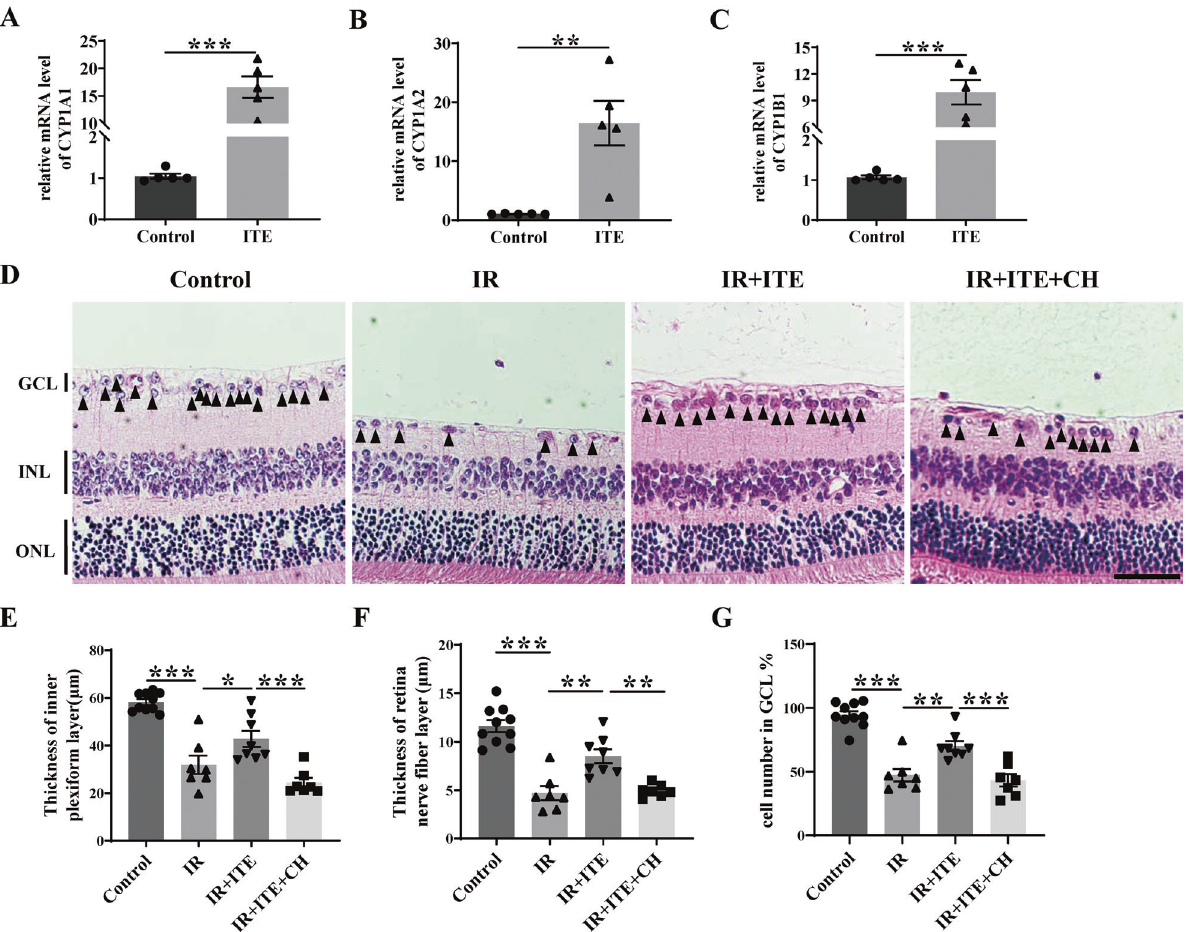
Fig. 3 The protective role of ITE in alleviating retinal injury was AhR activation dependent. Retinal ischemia/reperfusion injury model mice were intraperitoneally injected with ITE or CH223191 (10 mg/kg, inhibitor of AhR and abbreviated as CH below). A – C mRNA expression of CYP1A1, CYP1A2, and CYP1B1 were detected by qRT-PCR in the retina of mice with or without ITE administration for 24 h. D H&E staining showed different histology of retinas 7 days after IR. GCL ganglion cell layer, INL inner nuclear layer, ONL outer nuclear layer. Scale bars: 50 μ m. E – G Quantitative analysis of the thickness of inner plexiform layer and retina fi ber layer and cell number of ganglion cell layer were shown in histograms. Control, control group; ITE, ITE treatment; IR, ischemia/reperfusion injury; IR + ITE, IR with ITE treatment; IR + ITE + CH, IR with ITE and CH223191 treatment, n = 5 – 10 for each group. All data are presented as mean ± SEM, * P < 0.05, ** P < 0.01, *** P < 0.001, P value was obtained either by Student ’ s t test or by one way ANOVA followed by multiple comparisons. Each dot in graphs represents data from an individual retina from